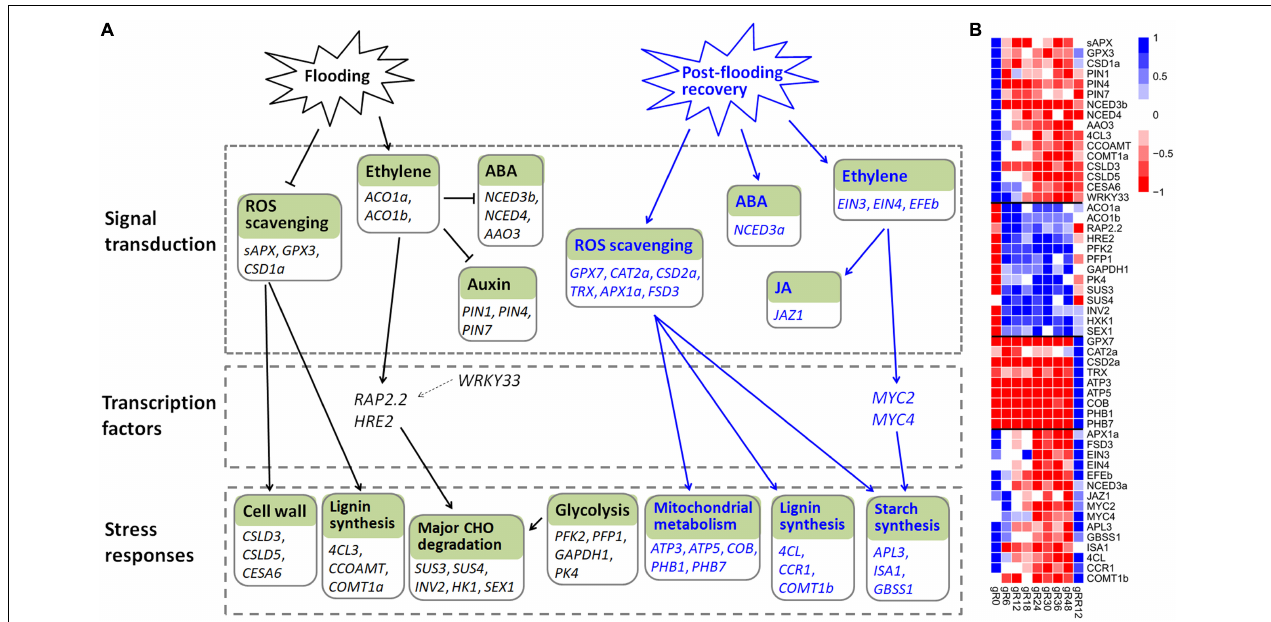
FIGURE 8 | The transcriptional regulation model of M. laxiflora during flooding stress. (A) The transcriptional regulatory networks of M. laxiflora upon flooding (black lines) and post-flooding recovery (blue lines) treatment. The normal arrows and T-bars indicate positive and negative regulation relationships, respectively. Solid lines represent the relationships that are consistent with previously reported studies, while dash lines represent the relationships reported in other plants but not confirmed in our work. (B) The transcriptomic profiles of genes present in (A) .